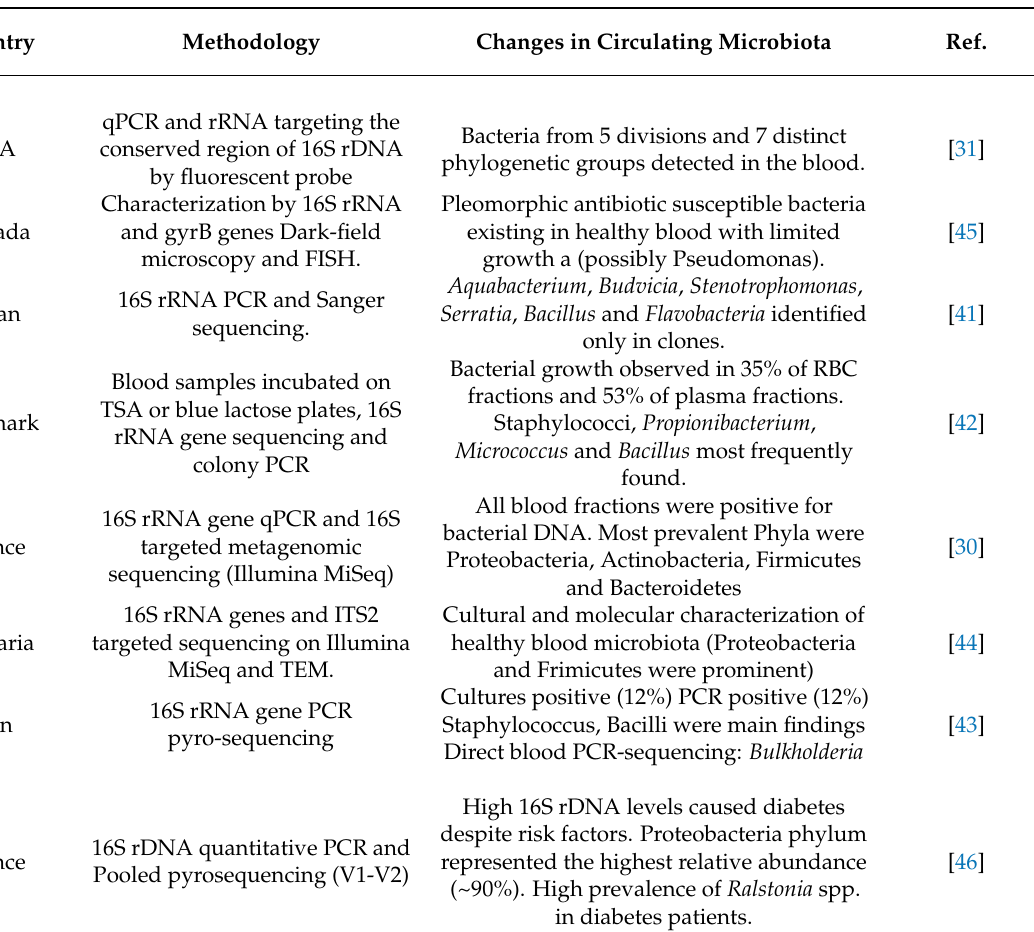
Table 2. Summary of different human blood microbiota studies conducted on healthy or diseased